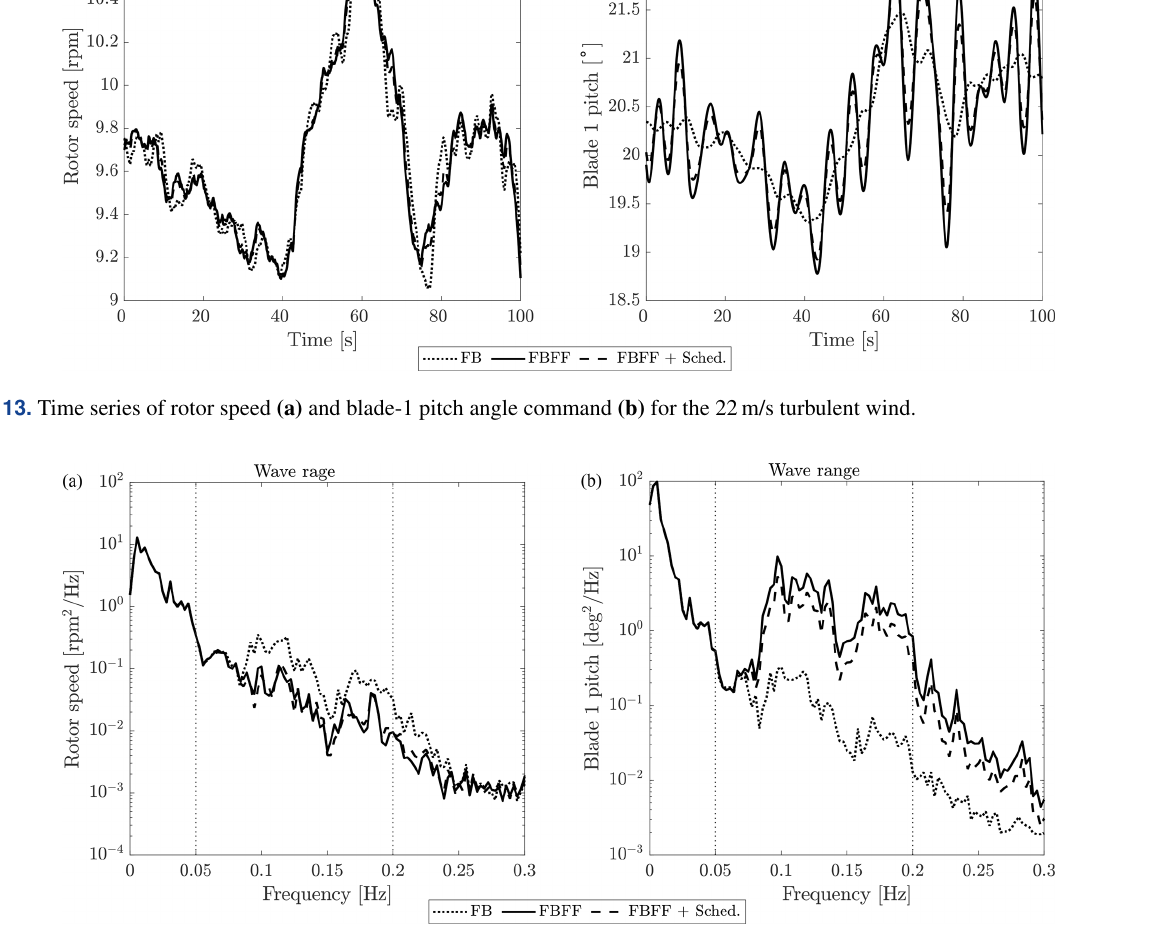
Figure 14. Power spectral density of rotor speed (a) and blade-1 pitch angle command (b) , aggregated time series of six seeds for the 22m/s turbulent wind case. Wave range is the frequency range where linear wave is